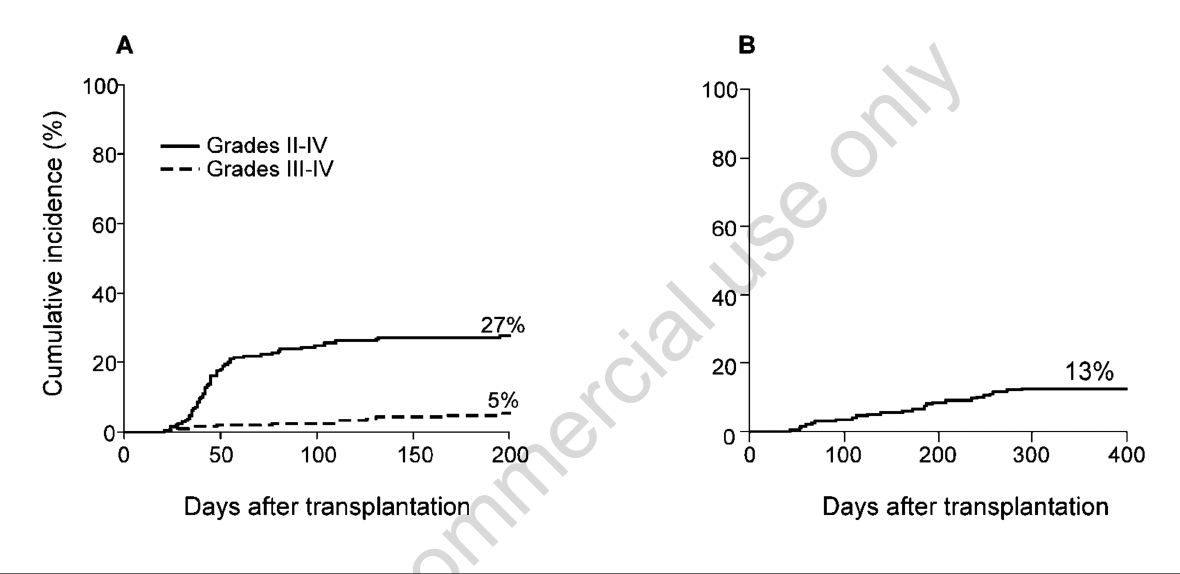
Figure 1. Treatment schema for nonmyeloablative conditioning regimine in HLA-haploidentical transplantation with post-transplanta- tion cyclophosphamide. MMF=mycophenolate mofetil; TBI=total body irradiation; Cy=cyclophosphamide; G-CSF=granulocyte colony stimulating factor.